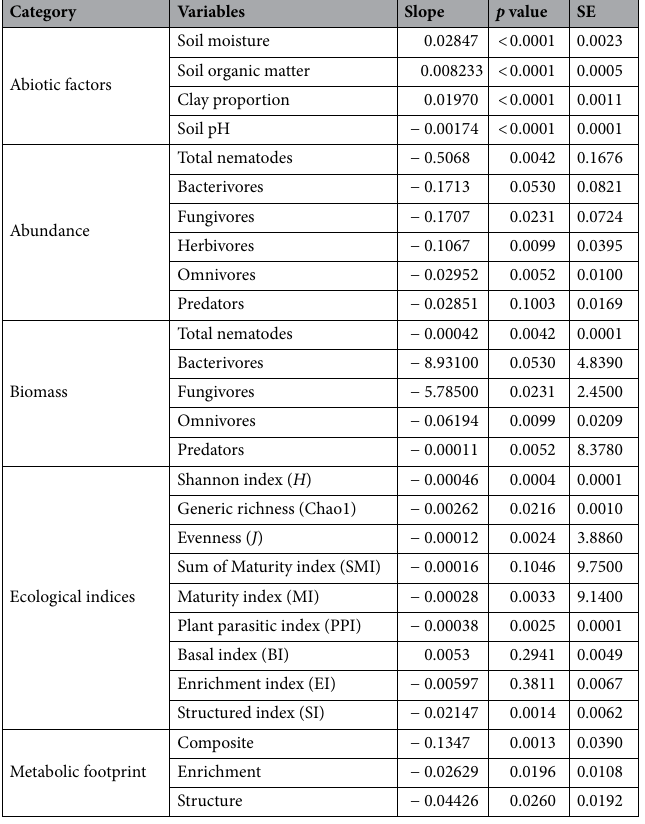
Table 1. Slope coefficients, p values and standard errors (SE) for linear regressions showing the relationships between elevation and abiotic factors, nematode abundance, biomass, ecological indices and metabolic footprint.